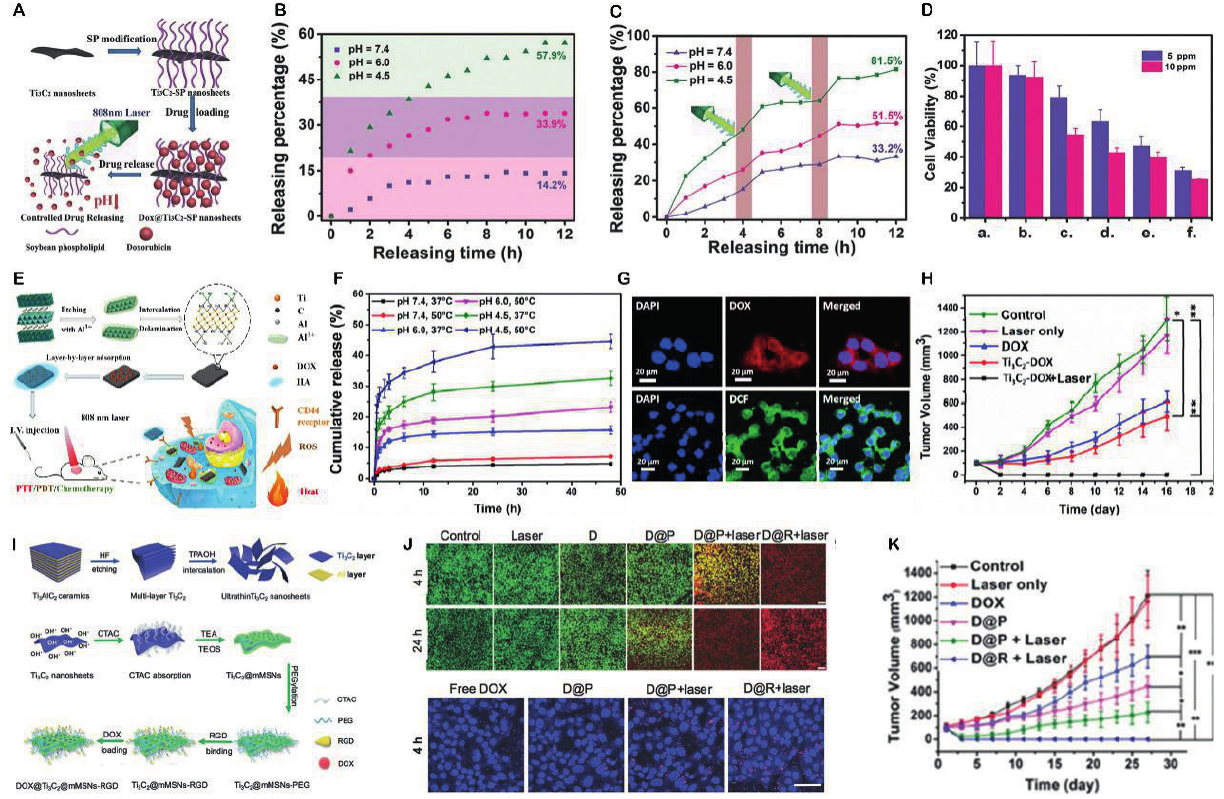
Figure 7: Synergistic and targeting therapy by various MXene system. (A) Schematic illustration of surface modification of Ti (B) pH-responsive DOX-releasing profiles. (C) Laser-induced DOX-releasing performance under different pH values (7.4, 6.0, and 4.5)